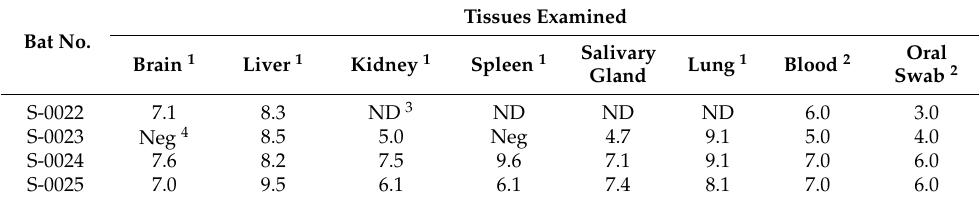
Tissues Examined